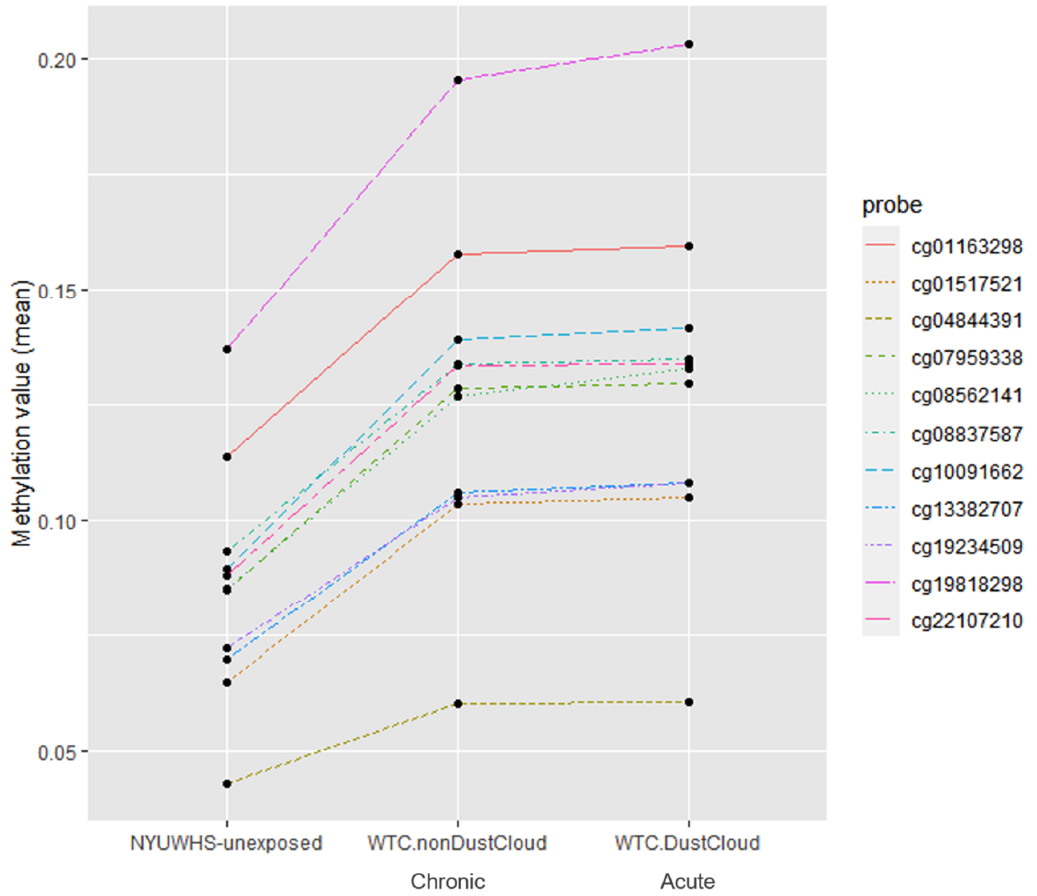
Figure 2. Mean methylation values of the top 11 differentially methylated probes of the WTC exposed groups (no dust cloud and dust cloud exposure) compared to the unexposed group (NYUWHS). Table 3. Methylation values of known tumor suppressor genes in the WTC-exposed (WTC EHC) cancer-free subjects compared to the unexposed cancer-free subjects